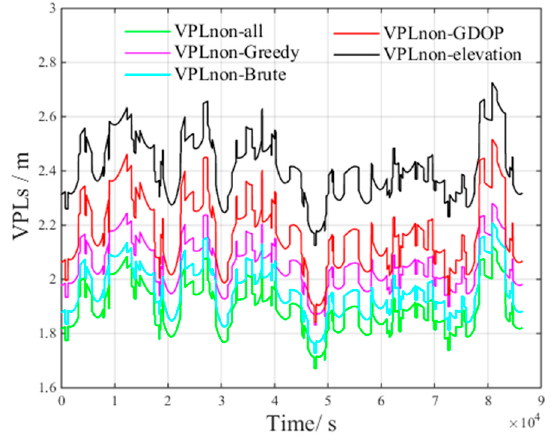
VPL of different methods under non-nominal troposphere. Figure 18. Figure 18. VPL non of different methods under non-nominal troposphere. non